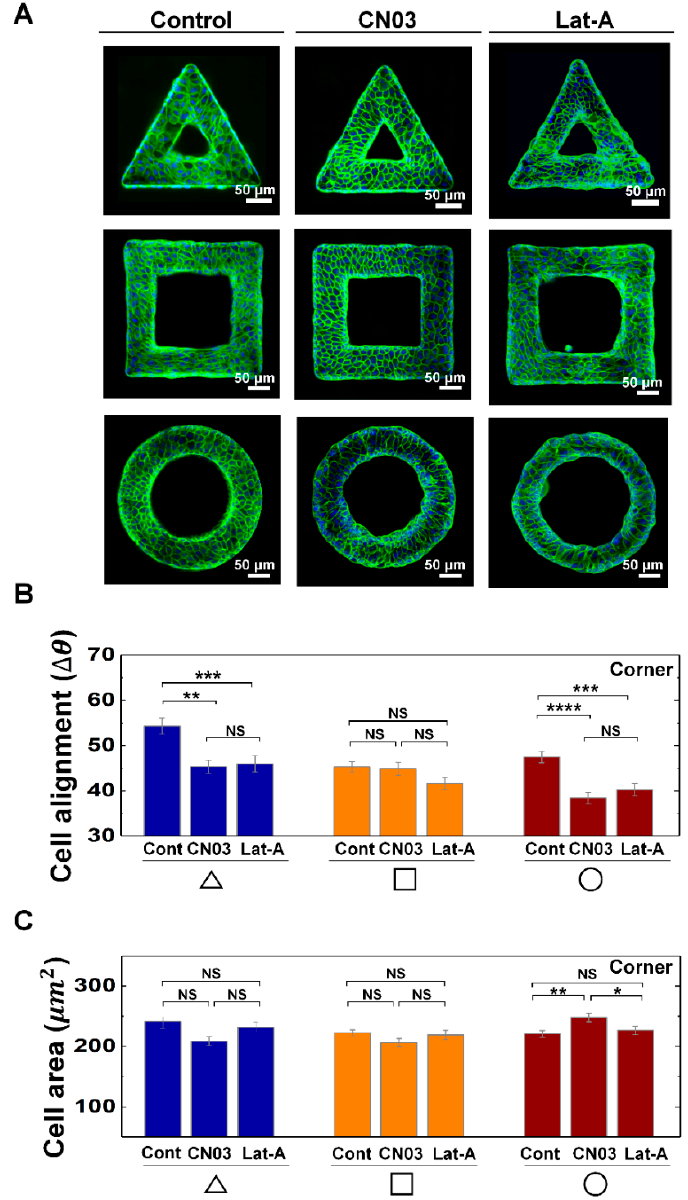
Figure 3. Actin contractility controls the morphological adaptation of MDCK cells on convex geometric structure. ( A ) Representative fluorescence images of MDCK cells on the 3D geometry treated with CN03 and Lat-A. F-actin (green) and nucleus (blue) were stained with phalloidin-FITC and 4 (cid:48) ,6-diamidino-2-phenylindole (DAPI), respectively. Averaged ( B ) ∆ θ , and ( C ) area of the cells on corner of triangle (navy), square (orange), and circle (red) structure with CN03 and Lat-A. N cell for CN03 treatment on the triangle, square and circle structure were 198, 364, and 430, respectively ( N = 3). N cell for Lat-A treatment on the triangle, square and circle structure were 287, 343, and 435, respectively ( N = 3). Error bars in graph indicate S.E.M. One-way ANOVA test with post-hoc Fisher’s LSD was used. **** p < 0.0001; *** p < 0.001; ** p < 0.01; * p < 0.05; NS, not significant.